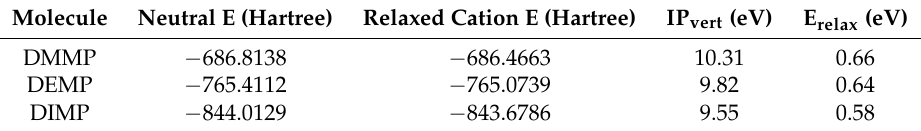
Table 1. Computed ionization and relaxation energies.